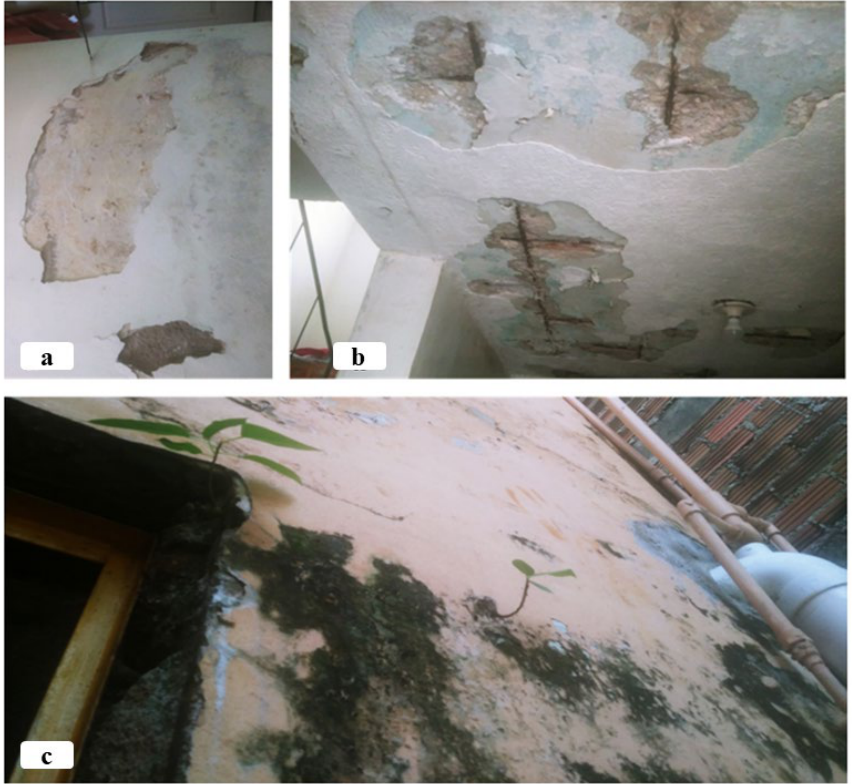
Figure 4. Single-family household obsolete plumbing installation affectations. ( a ) Interior dampness, ( b ) exposed structural reinforcement due to dampness, and ( c ) exterior dampness.